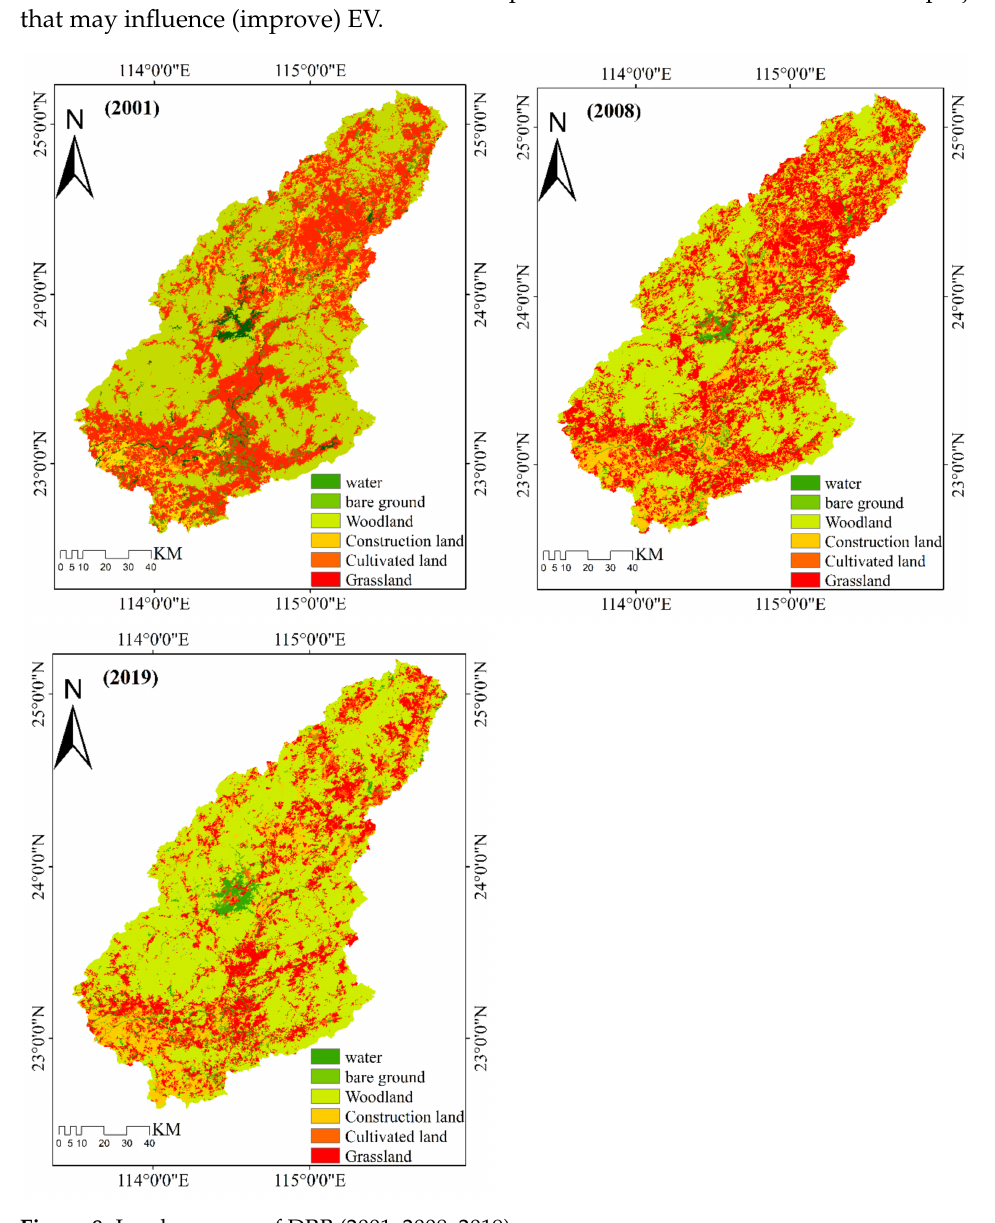
Figure 8. Land use map of DRB (2001, 2008,